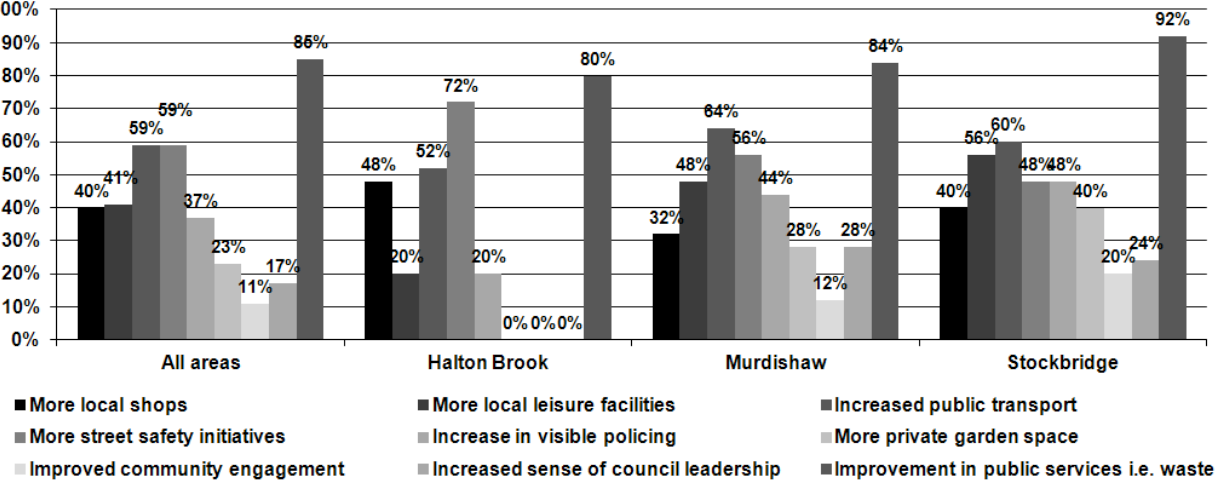
Figure 10. Aspirations of residents with respect to different areas of local quality of life.